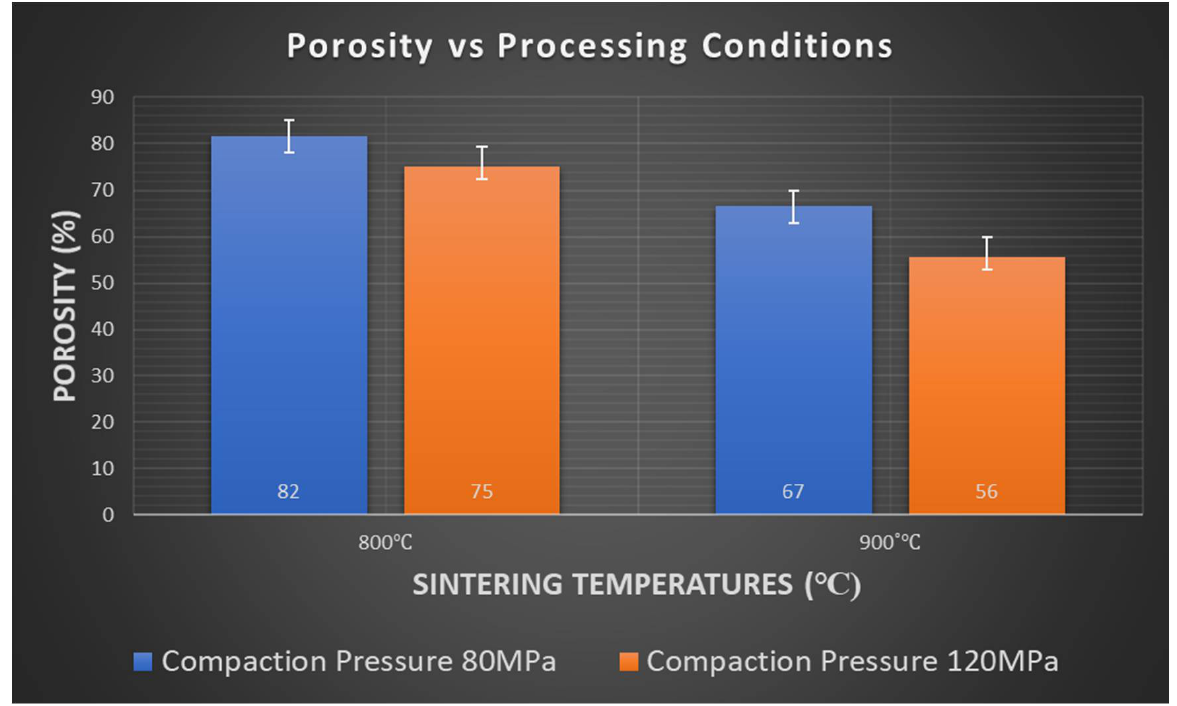
Figure 11. Variation in porosity with respect to initial compaction load and sintering temperatures.